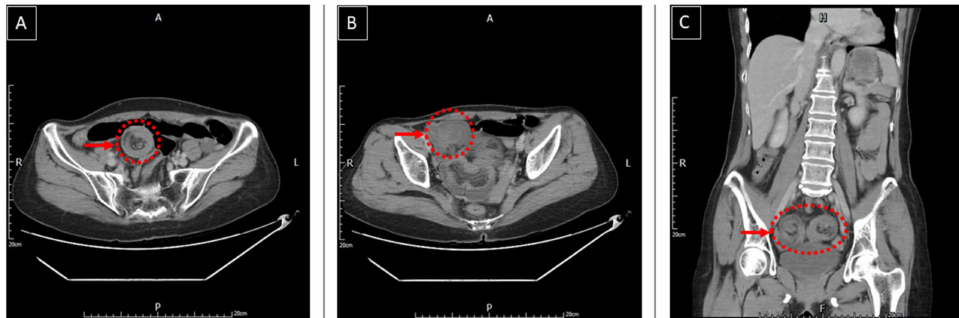
Figure 2. Abdominal computed tomography (CT); ( A ) The axial CT demonstrates an ileoileal intussusception with an accompanying complex of mesenteric fat and blood vessels, surrounded by the thick-walled intussuscipiens; ( B ) The axial CT demonstrates an ileocolic intussusception with associated bowel wall thickening and proximal small bowel dilatation; ( C ) The coronal CT demonstrates two target lesions with both ileoileal and ileocolic intussusception.